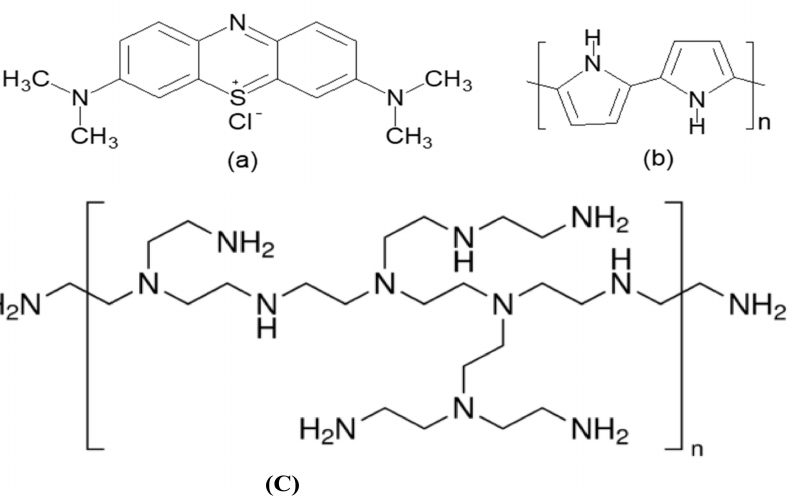
Figure 1. Molecular structure of ( a ) MB (an adsorbate) and ( b ) PPy (adsorbent) and ( c )